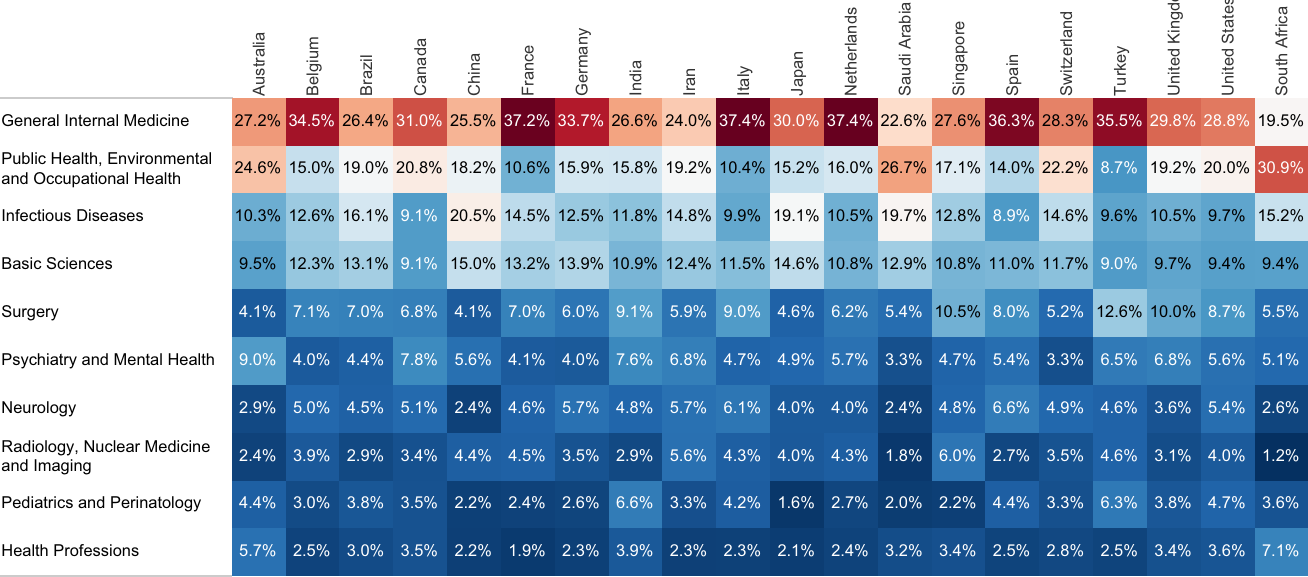
Fig 7. Distribution of the publications among the top ten medical subjects for the 20 leading countries in publication count.